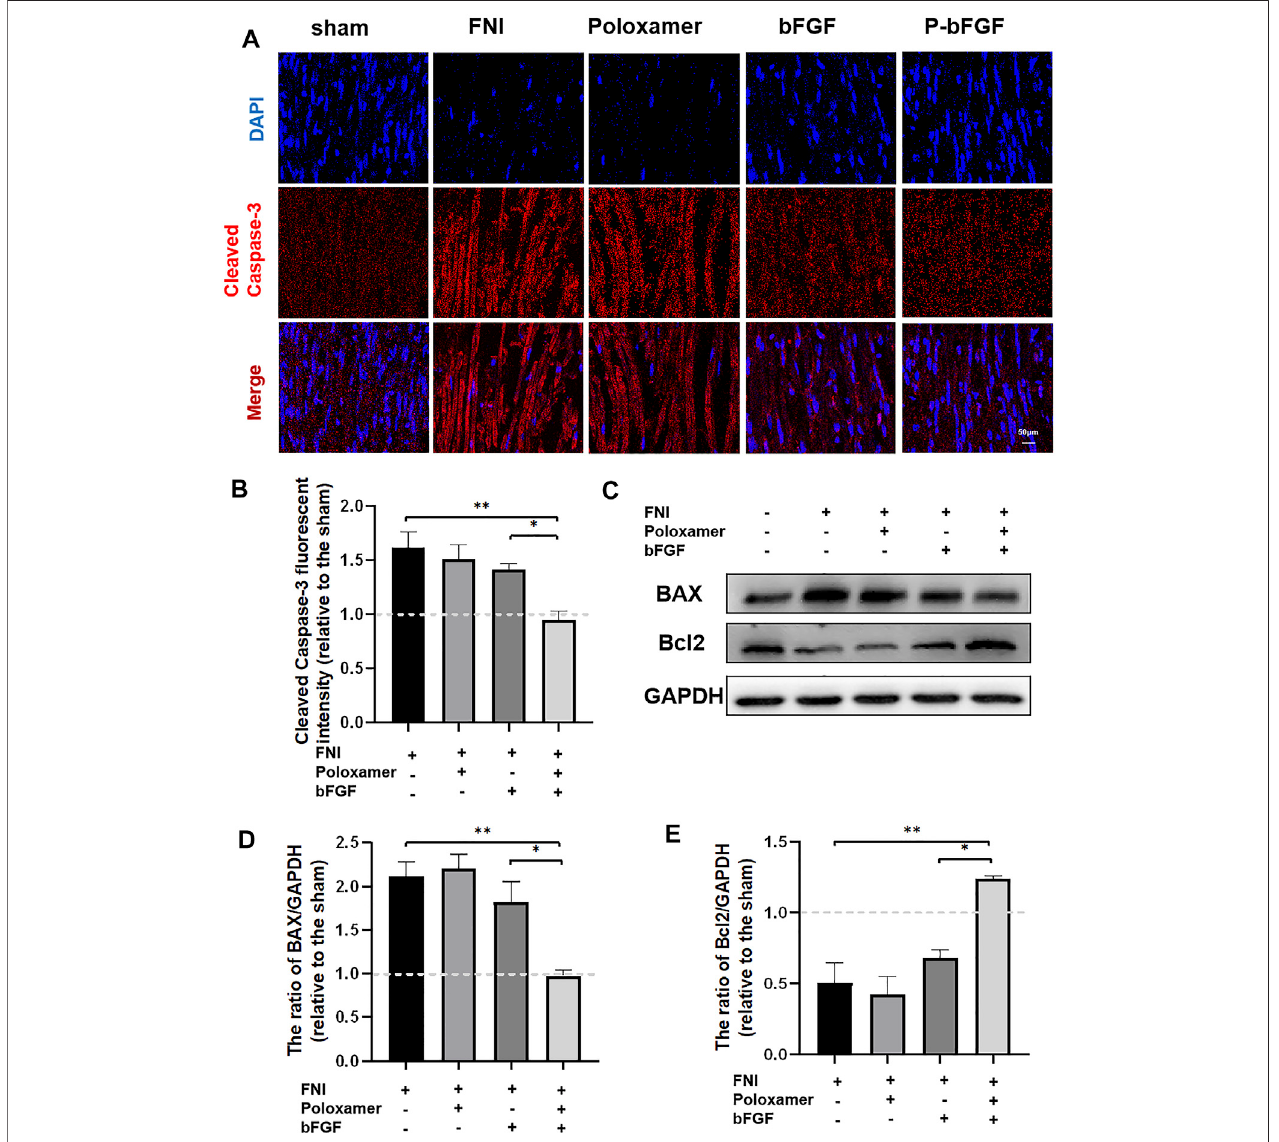
FIGURE 4 | P-bFGF inhibited apoptosis in order to promote facial nerve repair. (A) Representative immuno fl uorescence staining of Cleaved Caspase-3 of the injured nerves 2 weeks after treatment; Scale bar = 50 μ m. (B) Quantitative calculation of the mean of Cleaved Caspase-3 fl uorescence. The data were expressed as mean ± SEM ( n = 4); FNI group vs. P-bFGF group: ** p < 0.01, bFGF group vs. P-bFGF group: * p < 0.05. (C – E) Representative western blot images of BAX and Bcl2 expression in FNI 7 days after treatment and quanti fi cation of protein levels. The data were expressed as mean ± SEM ( n = 3); FNI group vs. P-bFGF group: ** p < 0.01, bFGF group vs. P-bFGF group: * p < 0.05. A dashed line at 1.0 represented sham